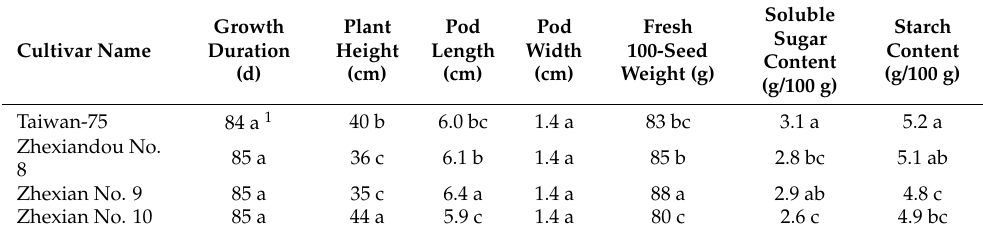
Table 1. Means of some characters for the four cultivars over 2 years.